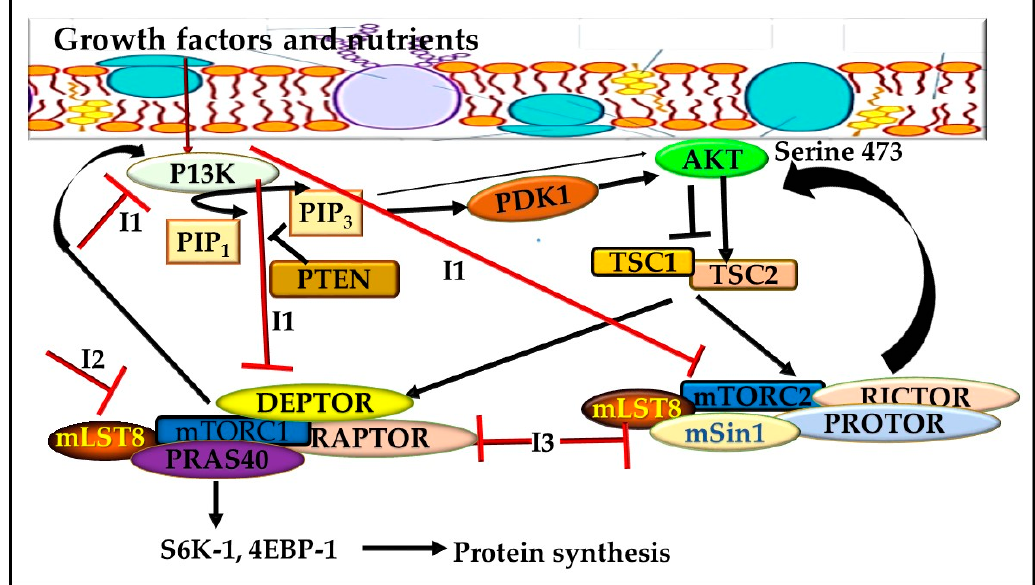
Figure 2. mTOR Signaling pathway. Activation of P13K phosphorylates phosphatidylinositol 4,5-biphosphate (PIP2) to form phosphatidylinositol-3,4,5-triphosphate (PIP3). Phosphatase and tensin